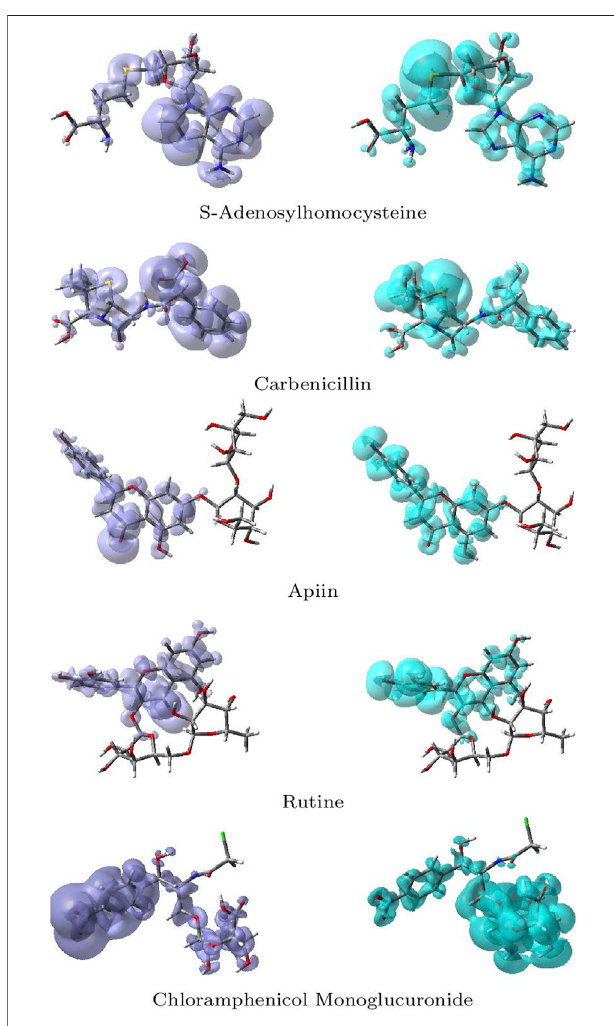
FIGURE 12 | Graphical representations of the dual descriptor DD of the fi ve studied ligands. Left: DD < 0, Right: DD < 0.